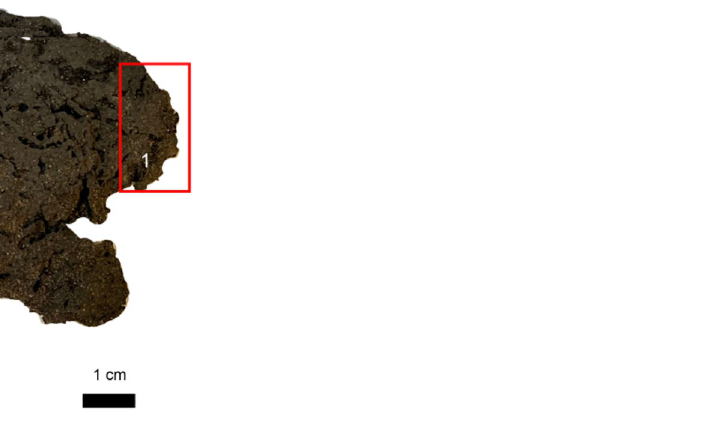
Figure 9. Sampling sites of brain MI CG 21 O-US4-1000 for histological investigation. Square named as 1 referred to the frontal cortex; square labeled as 2 was the occipital brain area, and square called 3 referred to parietal brain